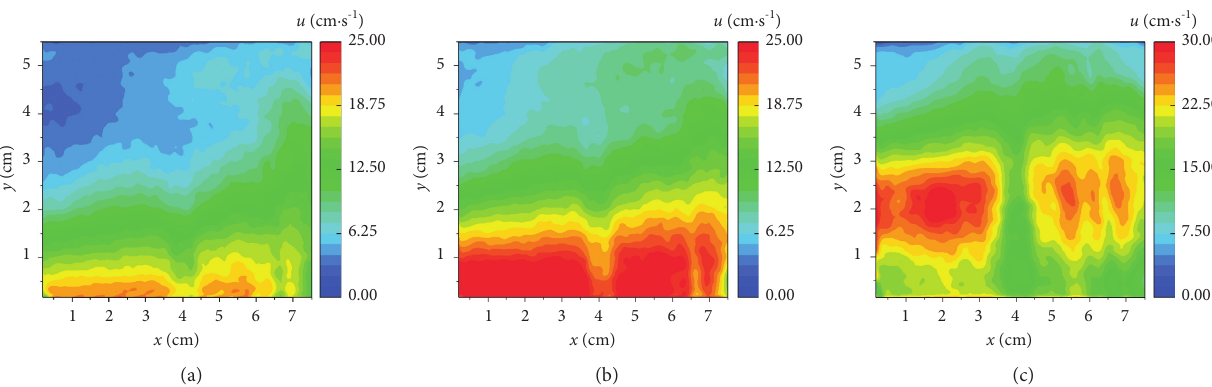
Figure 11: The distribution of the lateral turbulent intensities in different working conditions. (a) B25S. (b) B25M. (c) B25L.